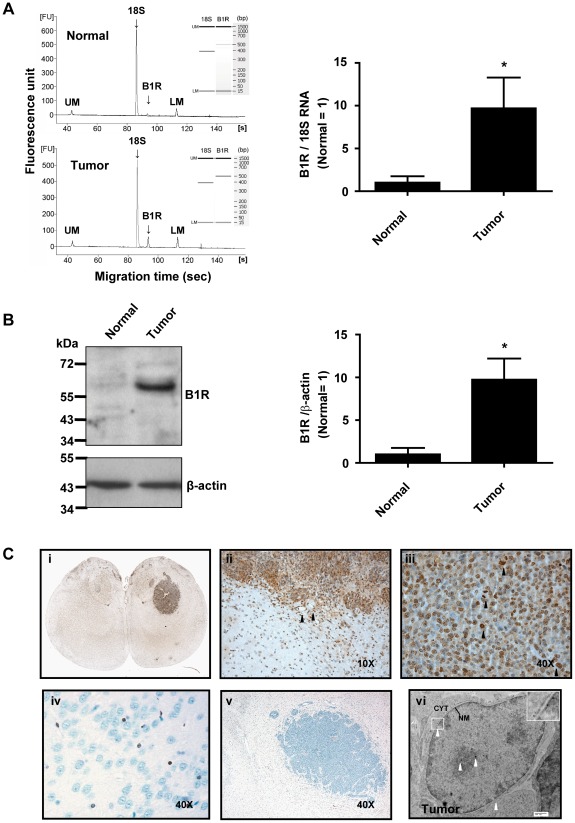
B1R expression in normal cerebral cortical and tumoral tissues of F98 glioma-bearing rats.(A) Left: Representative electropherograms and gel-like images (insets) of RT-PCR products amplified from one tumor and autologous controlateral tissue (normal); LM and UM correspond to lower and upper internal markers, respectively. Right: Histographic representation of B1R expression from multiple normal and tumoral tissues. B1R mRNA level was normalized to the corresponding 18S level for each biopsy. n = 5 rats. *p<0.05 vs normal. (B) Western blot of rat brain soluble protein extracts probed with the anti-B1R antiserum AS434. Left: Rat brain tumor shows a robust single immunoreactive band around 60 kD. In the absence of antiserum, no band was seen in the rat brain samples (not shown). Right: Histographic representation of B1R expression from multiple normal and tumoral tissues. B1R protein level was normalized to the corresponding β-actin level for each biopsy. n = 4 rats. *p<0.05 vs normal. (C) The antiserum used for Western blot was also used to characterize the location of the proteins in rat brain cortical samples by IHC, along with HRP (panels i–v), and TEM immunogold labeling (panel vi). Photomicrographs illustrating positive B1R immunoreactivity in tumor (C, i–iii) and microvascular endothelial cells (ii) adjacent to the tumor (black arrowheads). Note the chromosomal staining on all tumor cells under mitosis (black arrowheads, iii). Negative control with preimmune serum showed no staining (v). Weak positive B1R staining of glial cells from both implanted (ii) and contralateral hemispheres (iv) is also shown. Magnification as indicated. EM photomicrograph (vi) showing subcellular localization of B1R in a glioma cancer cell (white arrowheads). Insert: digital enlargement of the delineated area (white rectangle) showing B1R immunoreactivity at both the inner and outer leaflets of the nuclear envelope. Scale bar = 500 nm. Photomicrographs of HRP labeling were equalized in terms of contrast, brightness and gamma using ImagePro Plus 5.1.